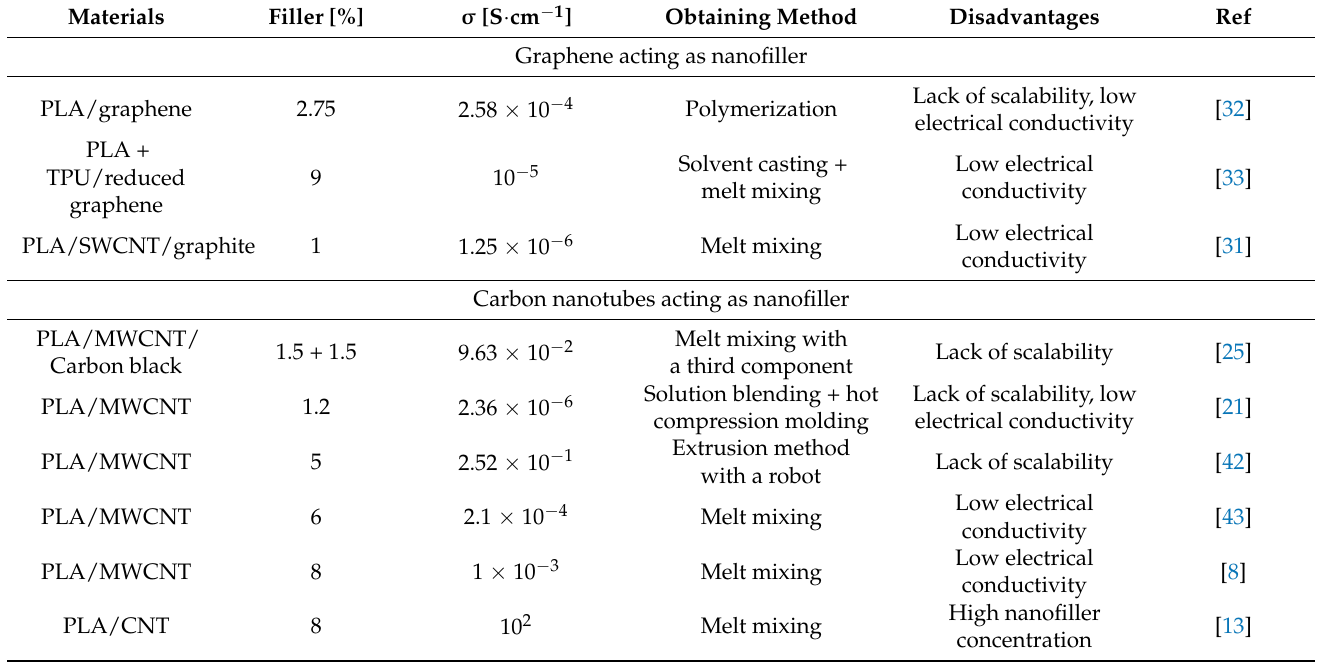
Table 1. State of art historical review of reported studies with conductive PLA